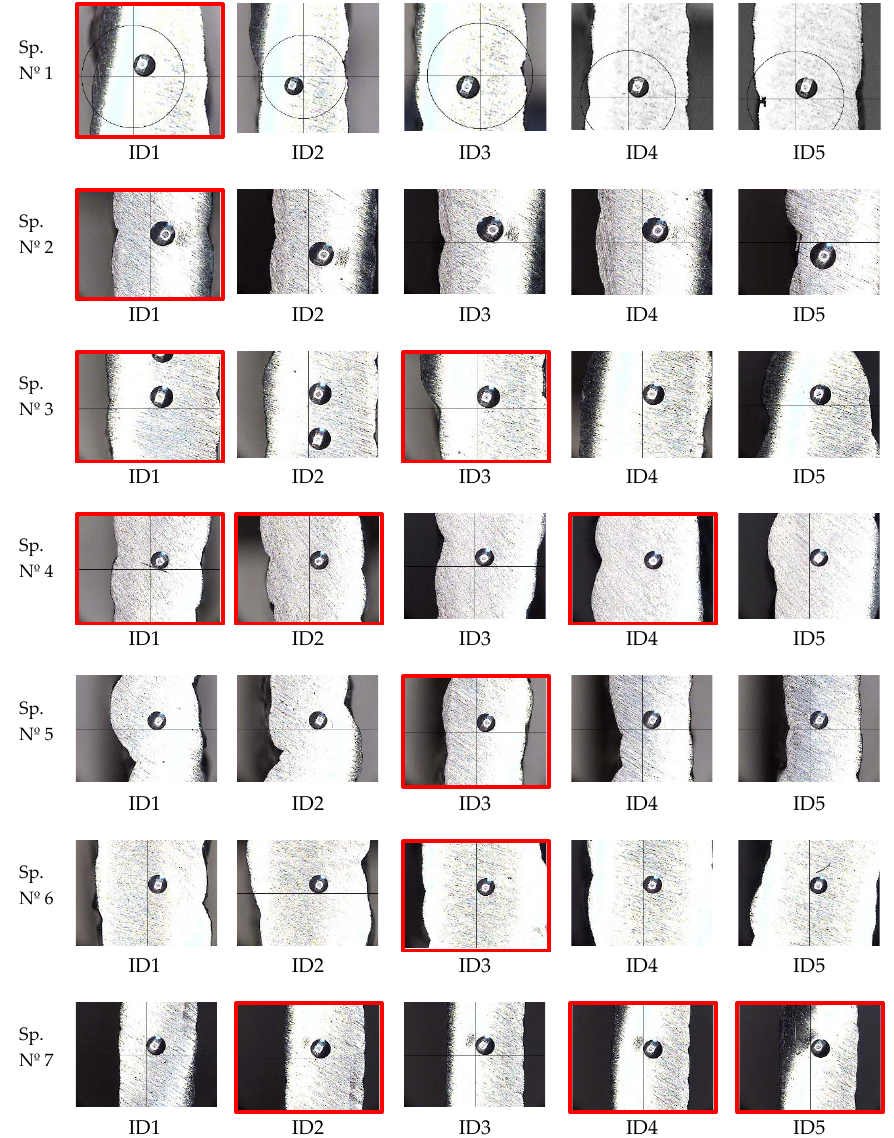
Figure A1. Brinell hardness tests applied to WAAM samples and identification of indentation points; images with red frame showing points located more clearly between layers.